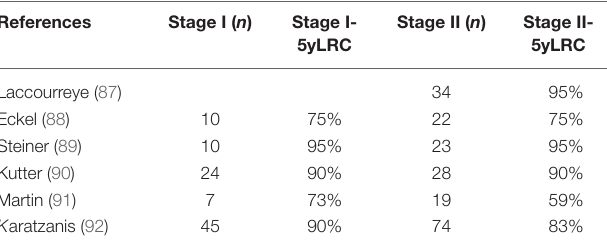
TABLE 2 | Results of early stage hypopharynx cancer patients in selected surgical